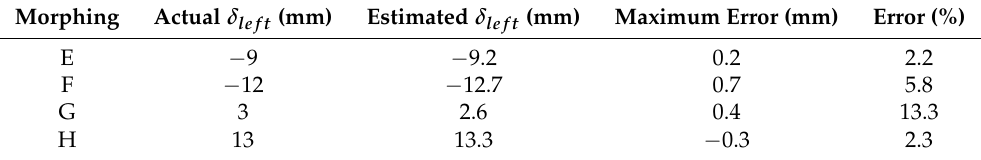
Table 8. Model estimated left deflections of the wing during twisting due to arbitrary morphing E to